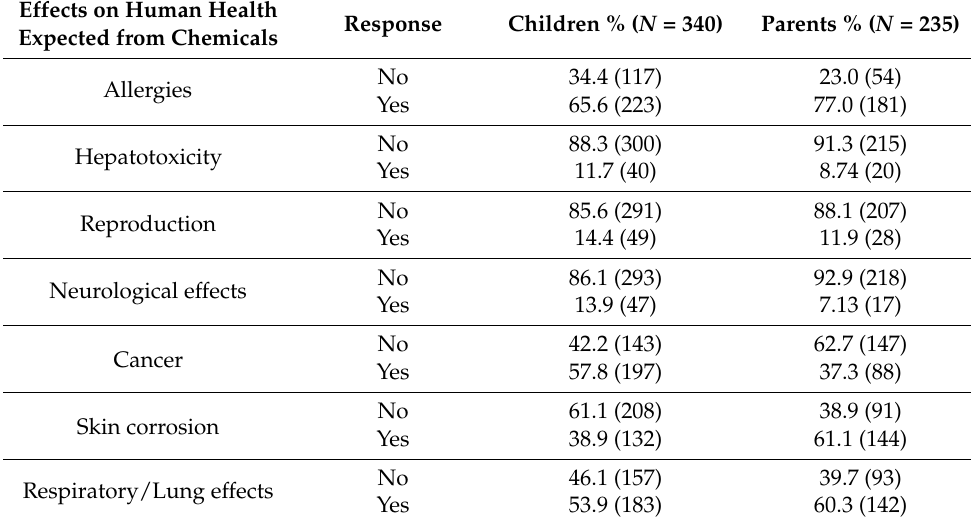
Table 2. Awareness of the study population regarding any possible effect of chemical product use on the human